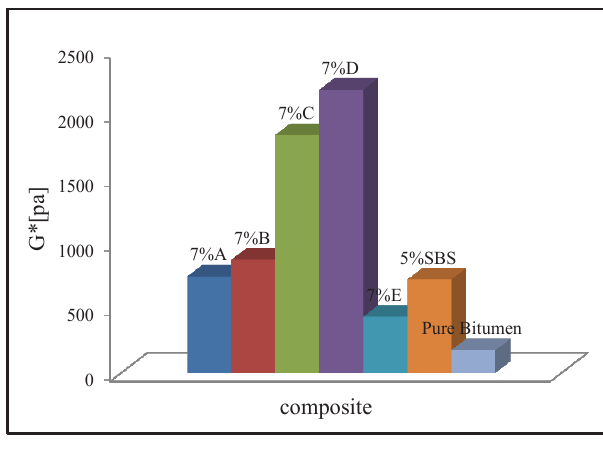
Fig. 7. complex modulus of the pure bitumen and the modified ones at 80.1 o C.